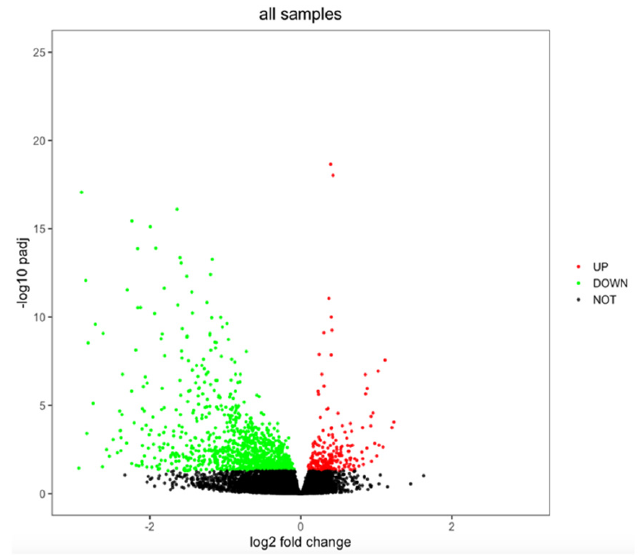
Figure 1. Volcano plot showing sex differences in gene expression in DLBCL. Genes were considered to be differentially expressed when adjusted p -value < 0.05. Upregulated genes are marked in red, downregulated genes are marked in green, and not significant genes are marked in black.